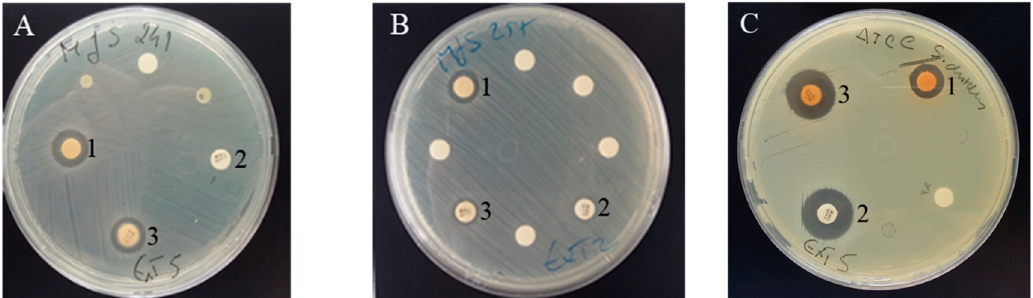
Figure 5. Clinical isolates of S. aureus MJS241 ( A ), E. faecalis MJS257 ( B ) and S. aureus ATCC ( C ) and the inhibitory effect of sweet cherry stem’s extracts. ( 1 ) Sweet cherry stem’s extract; ( 2 ) tested antibiotic (Gentamicin); ( 3 ) sweet cherry stem’s extract and tested antibiotic.